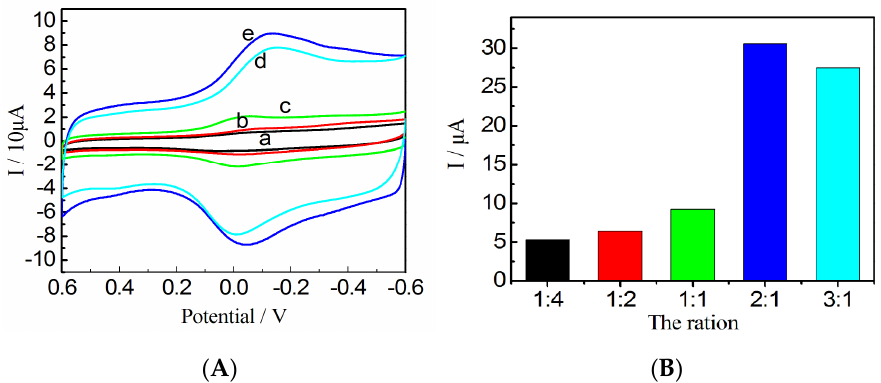
Figure 3. ( A ) CVs of the electrode modified with different ratio of MWCNTs/CeO 2 nanorods: 1:4 (a); 1:2 (b); 1:1 (c); 2:1 (e); 3:1 (d). ( B ) The relationship between the reduction peak current and the ratio of MWCNTs/CeO 2 nanorods.